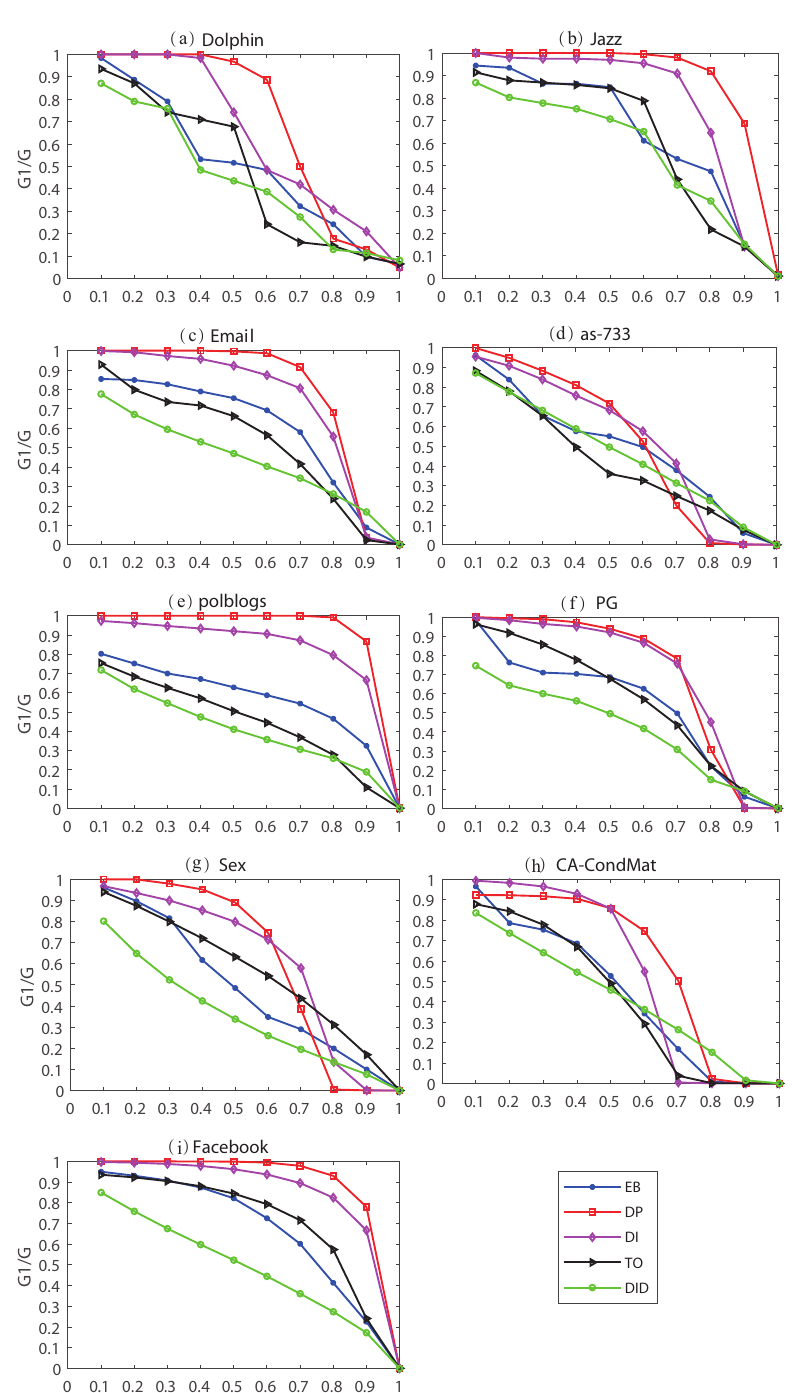
Figure 2. The dynamic damage of DID and 4 comparison algorithms to the real networks connectivity ( a – i